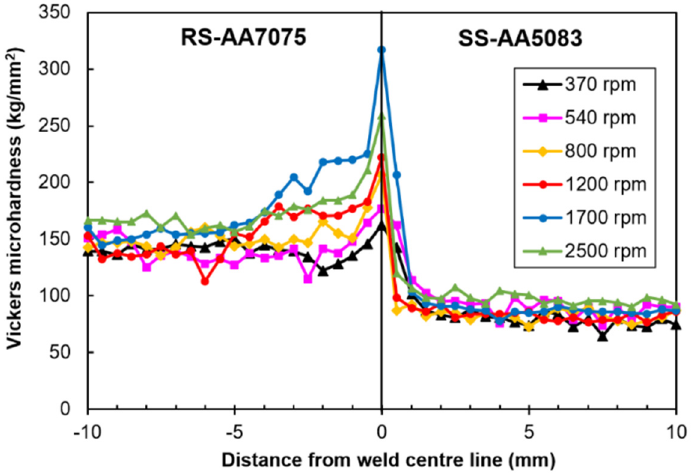
Figure 11. Microhardness distributions of the weld joints with AA7075 and AA5083 are located as rotary side (RS) and stationary side (SS) respectively.